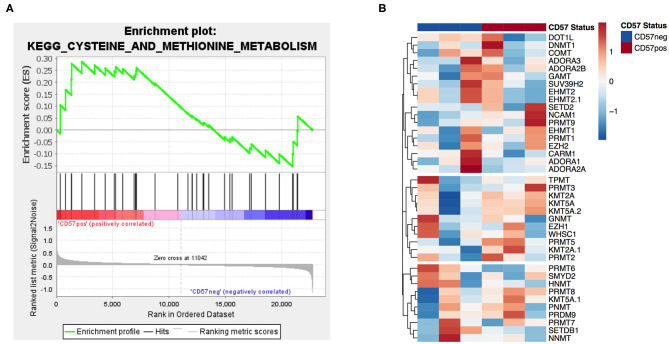
Gene expression of MTA's metabolic pathway and targets is similar in CD57+/− NK cells. Analysis of publicly available microarray data (GSE23695) (20) of CD56dimCD16+CD57+ and CD57− sorted NK cells performing a gene set enrichment analysis of the methionine and cysteine metabolism pathway (A) and a differential gene expression analysis of adenosine receptors and various methyltransferases (B). For the gene set enrichment analysis, the normalized enrichment score (NES) was 0.8 and the nominal p value 0.6.